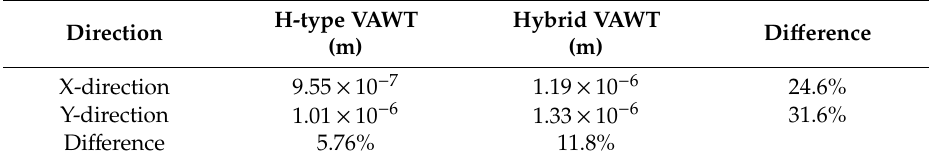
Figure 14. Forced transient responses of the 4 m ‐ mast H ‐ type and hybrid VAWTs in ( a ) X ‐ and ( b ) Y ‐ directions, and their steady ‐ state responses in the ( c ) X ‐ and ( d ) Y ‐ directions from 6.5 to 8.5 s. Table 11. Comparison of the maximum steady ‐ state response amplitudes of the 4 m ‐ mast H ‐ type and hybrid VAWTs in X ‐ and Y ‐ directions.